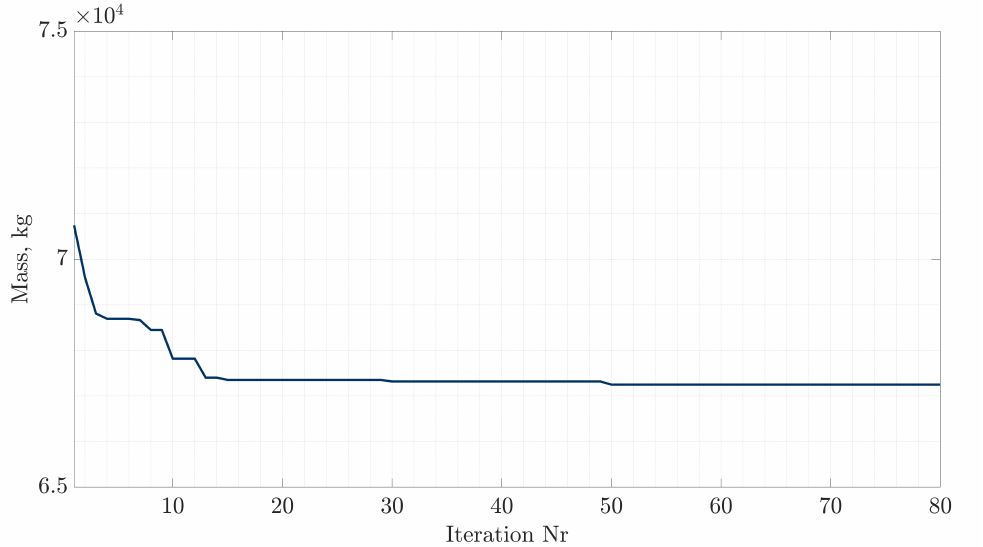
Figure 12. Convergence of the objective